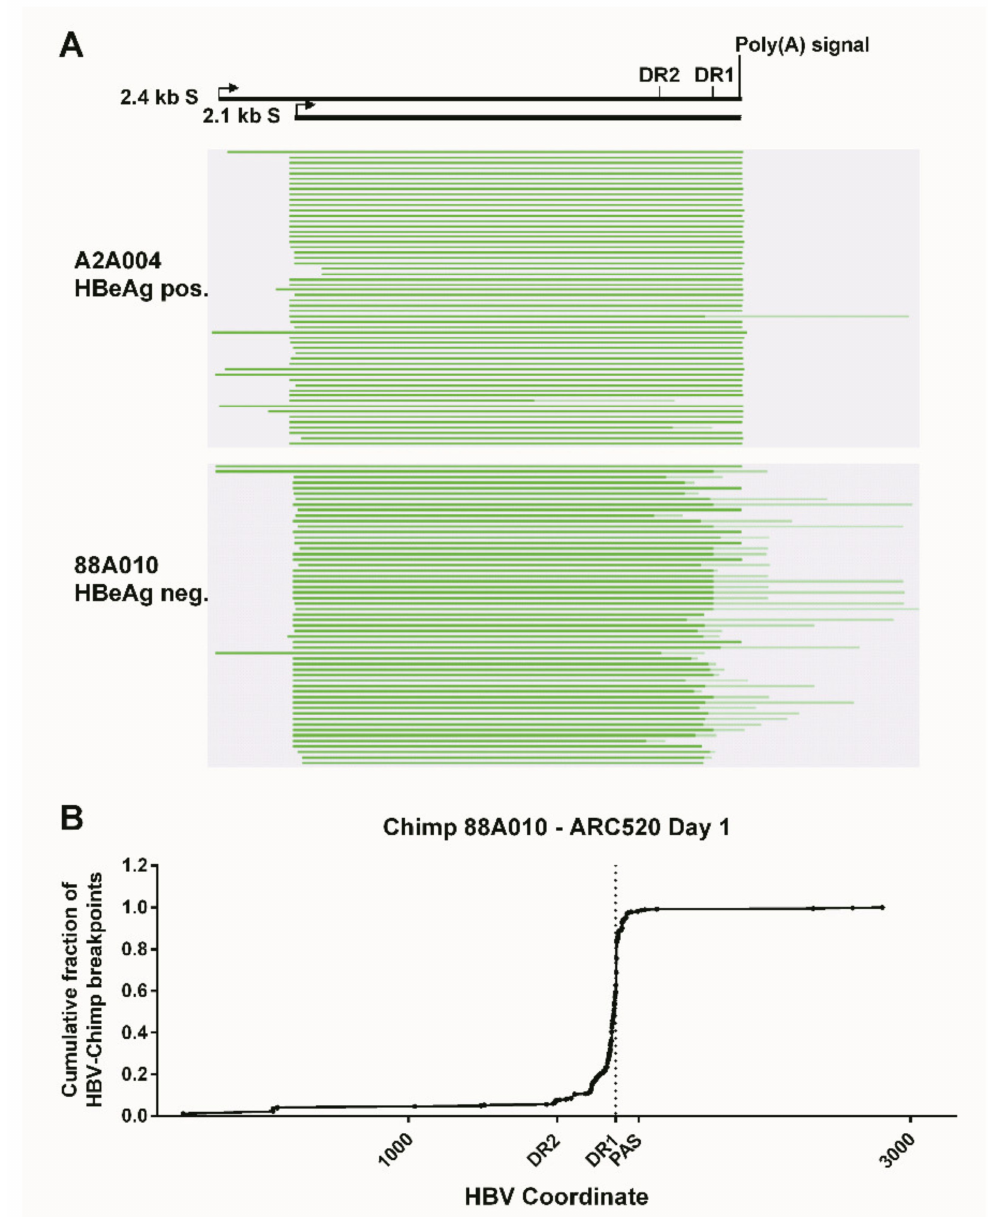
Figure 5. Mapping of HBV S transcripts from HBeAg-positive and HBeAg-negative chimpanzees. Total RNA isolated from the liver biopsies after the NUC lead-in and before ARC-520 dosing on day 1 from HBeAg-positive chimpanzee A2A004 and HBeAg-negative chimpanzee 88A010 was reverse-transcribed, size-selected, and sequenced with SMRT sequencing. ( A ) Full-length nonconcatemer reads were aligned to each chimpanzee’s consensus HBV DNA sequence. Green lines represent HBV containing transcripts. Dark green represents sequences aligning to HBV, and light green represents those not aligning to HBV. The HBV coordinates are shown with elements DR2, DR1, and the HBV polyadenylation signal. ( B ) Cumulative fraction of HBV-chimpanzee breakpoints was plotted against the HBV coordinate. From [1]. Reprinted with permission from